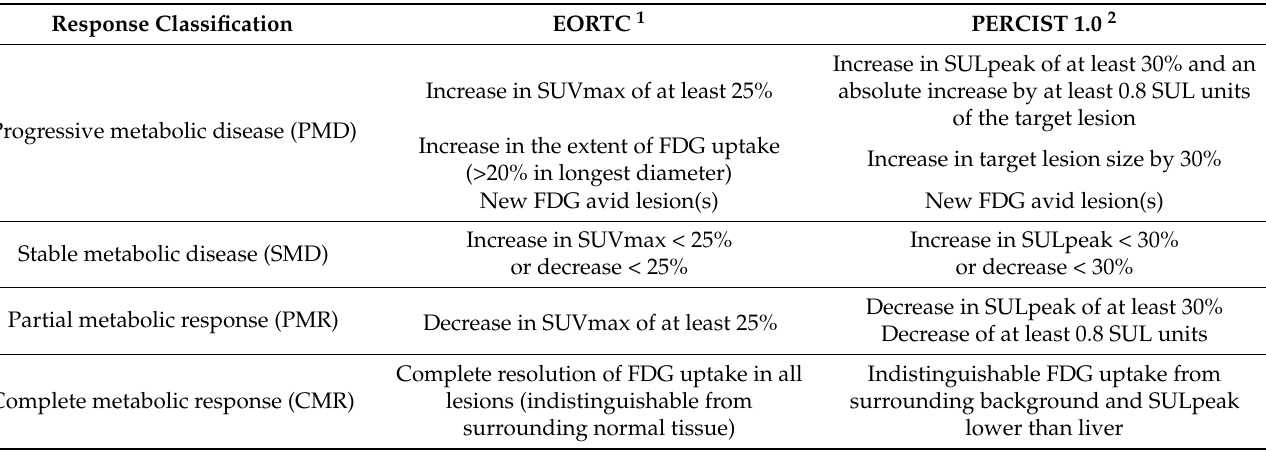
Table 1. Response classification by EORTC and PERCIST 1.0